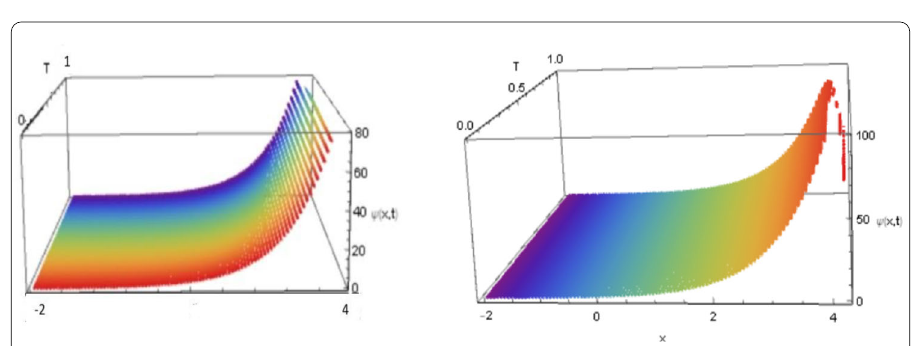
Figure 6 Surface plot to Example 2 at β = 1 exact solution (left) and using FVSF (right)